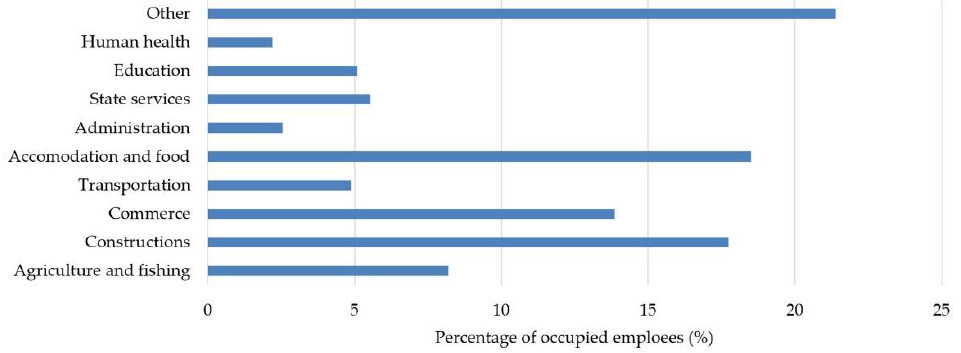
Figure 2. Percentage graph of the occupied employees on Sifnos per occupation category.